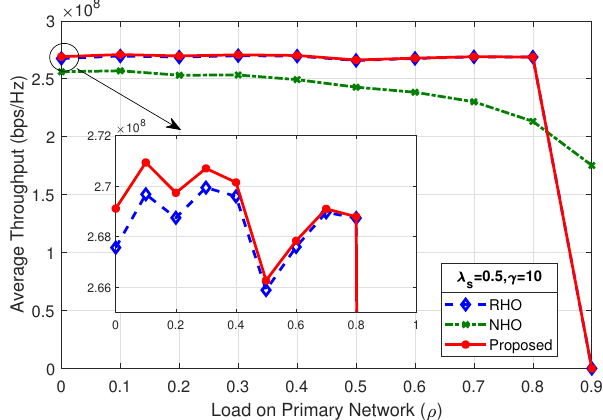
Figure 12. Average throughput of the system for λ s = 0.5, γ =